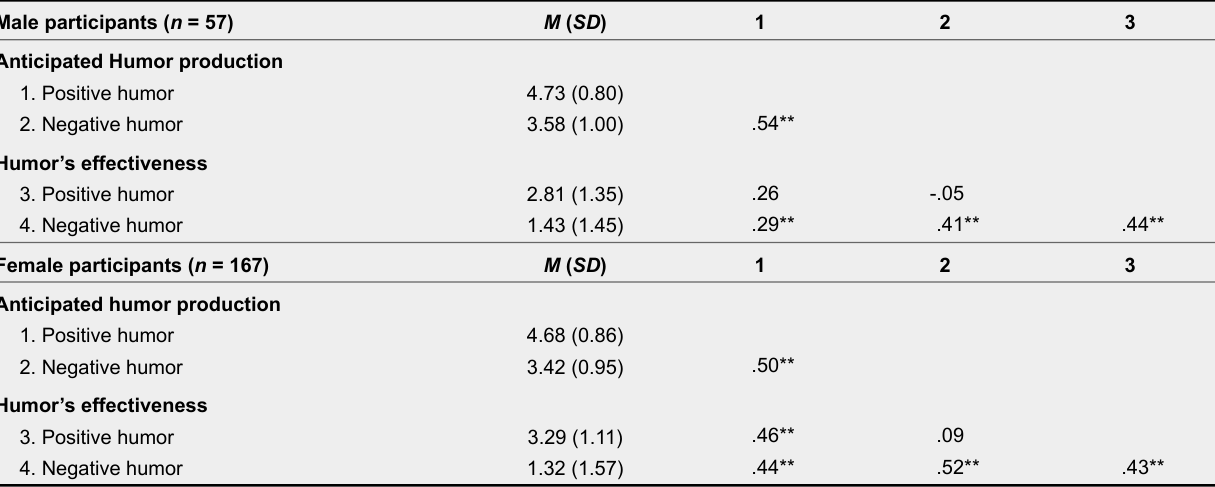
Means, Standard Deviations, and Correlations among Measures by Gender